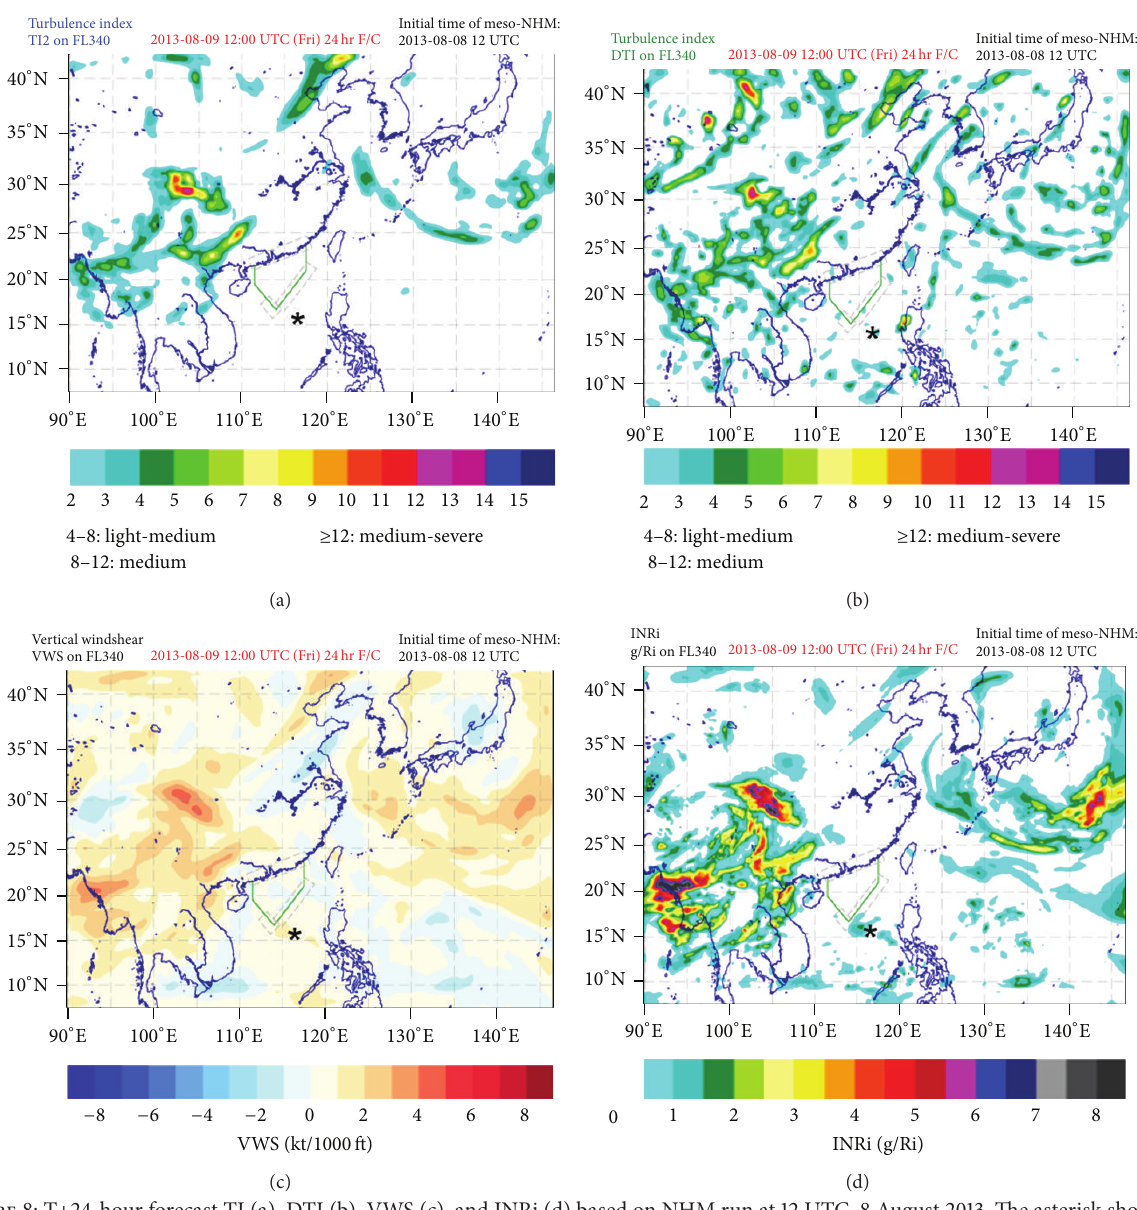
Figure 8: T+24-hour forecast TI (a), DTI (b), VWS (c), and INRi (d) based on NHM run at 12 UTC, 8 August 2013. The asterisk shows the location of the turbulence